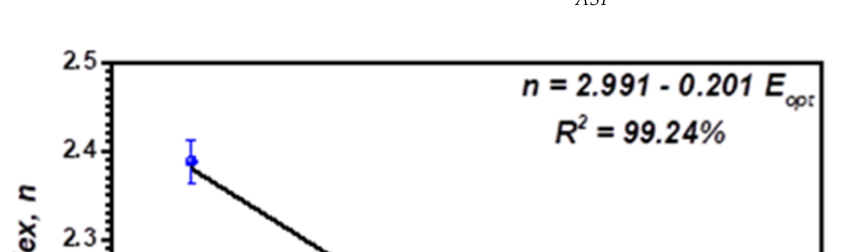
, of pristine PVA, PVP/PVA blend, ASF